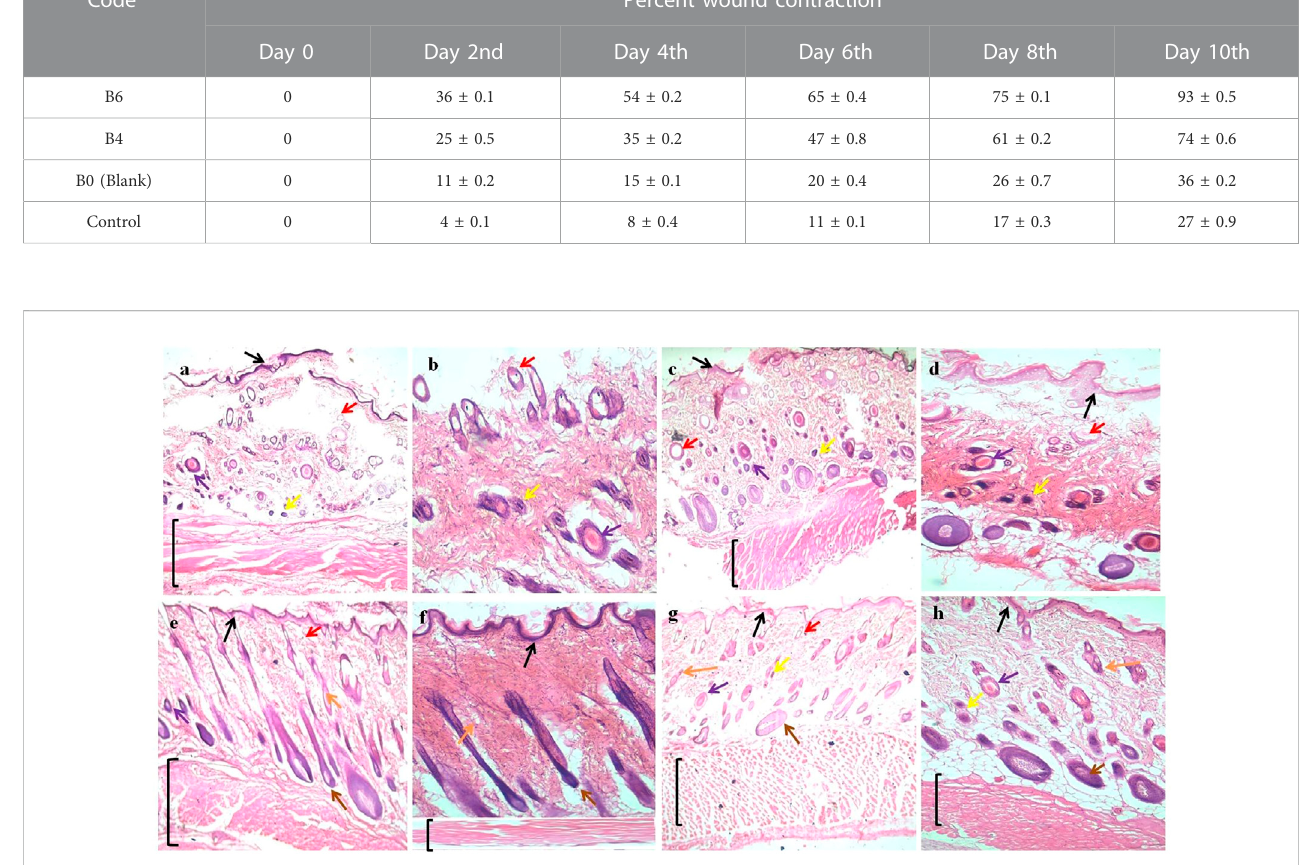
FIGURE 9 H&E (hematoxylin and eosin) straining of wound tissues micrographs; (A) and (B) control at 4x and 10x, (C) and (D) blank (B0) at 4x and 10x, (E) and (F) optimized formulation (B4) at 4x and10x, and (G) and (H) optimized formulation (B6) at 4x and 10x. Arrows indicate: Black = epidermis, Red = blood vessel, Purple = macrophages, Yellow = in fl ammatory cells, Orange = sebaceous gland, Brown = hair follicles, and Black bracket = connective